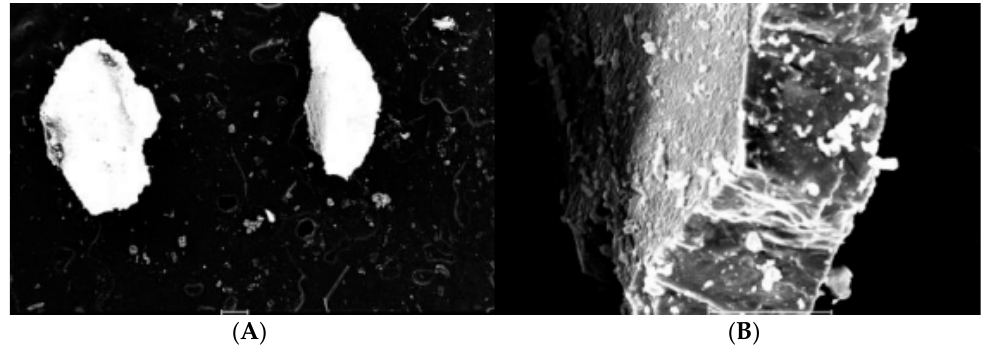
Figure 8. SEM images of ketoconazole inclusion complexes (×100, A ), (×500, B ).